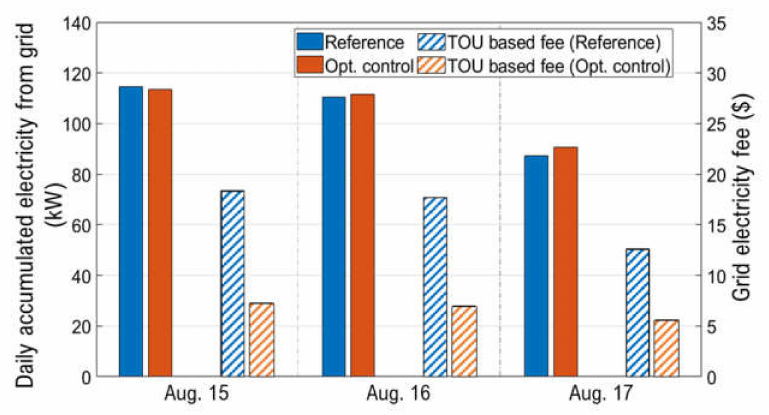
Figure 5. Comparison of grid energy consumption and cost of